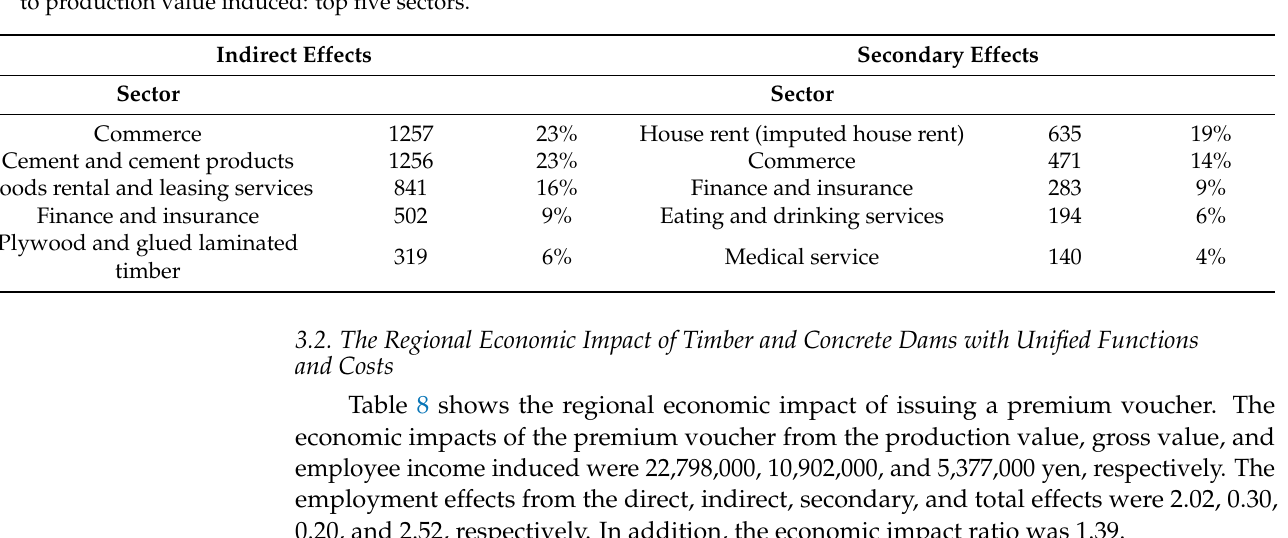
Table 7. Indirect and secondary effects (in thousands of yen) of the construction of a concrete dam, with percent contribution to production value induced: top five sectors.